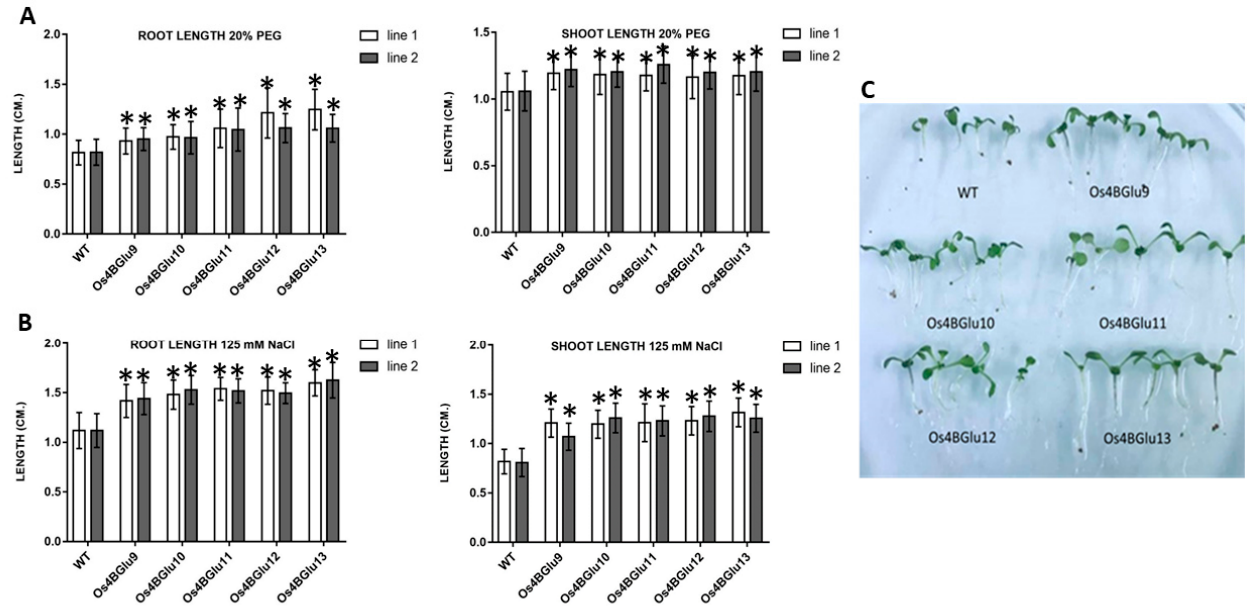
Figure 5. Effect of NaCl and osmotic stress on wild type and rice β -glucosidase-expressing Arabidopsis seedling roots and shoots. Control Arabidopsis plants and plants expressing Os4BGlu9-13 were grown on 1 / 2 MS plates for 7 d and transplanted to 1 / 2 MS containing 125 mM NaCl ( A , C ) or 20% PEG ( B ) for 5 d. To quantify growth response, root and shoot lengths were measured in three independent sets of 20 plants each for each line. White and black bars represent two lines of plants with heterologous expression of the same gene. Asterisks (*) above the bars indicate a significant difference from both control lines with p < 0.05.